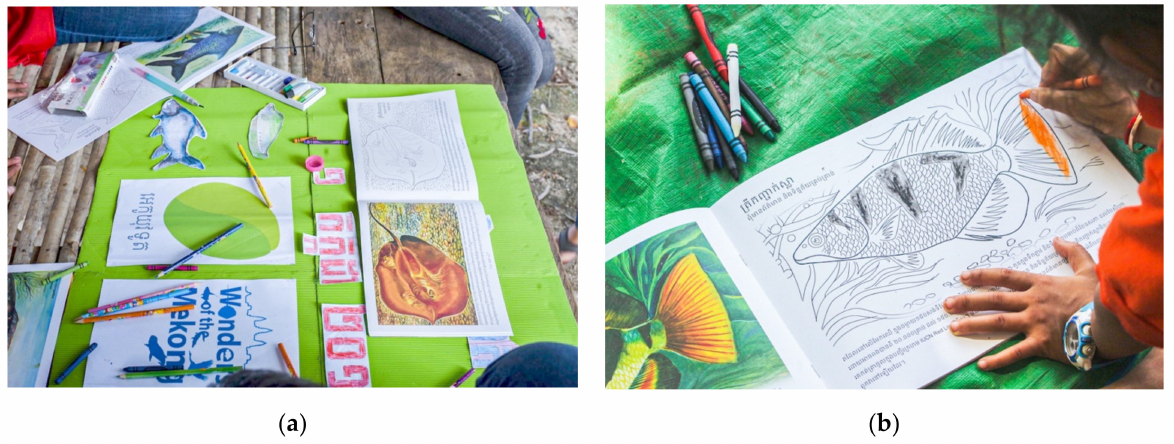
Figure 3. ( a ) Materials at a coloring event organized by Young Eco Ambassador; ( b ) a Cambodian child colors in the Wonders of the Mekong coloring